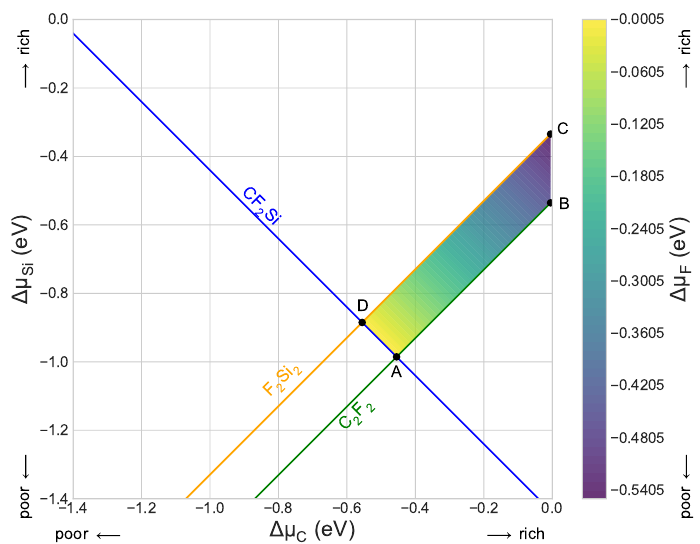
Figure 2. Chemical potential’s phase diagram, showing the region of stability of CF 2 Si in terms of the excess chemical potentials. (Color online) Variation in ∆ µ F formation enthalpy as a function of chemical potential, shown within the stability region for the formation of low dimensional CF 2 Si. Points A, B, C, and D are shown only in order to delimit the zone of